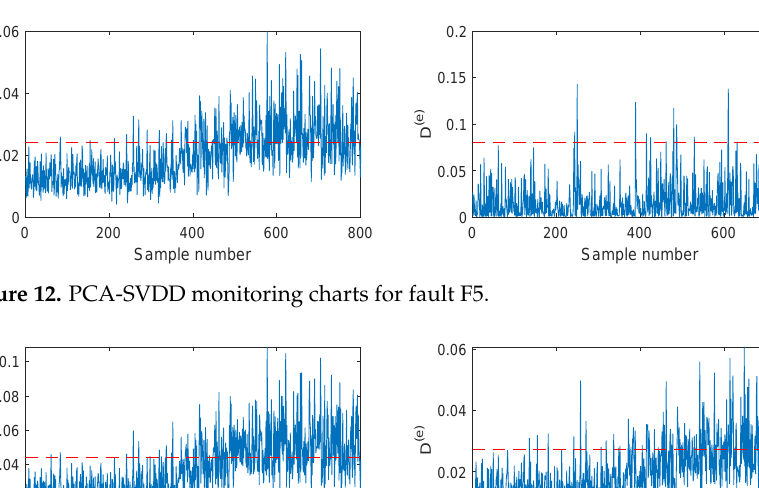
Figure 11. SVDD monitoring charts for fault F5.